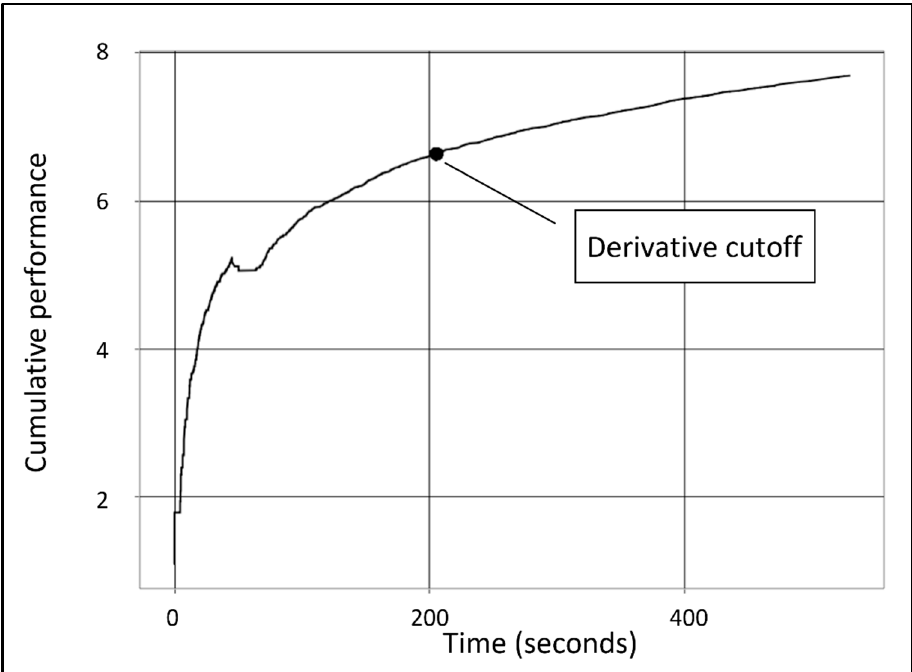
Figure 3. Learning curve for a single participant. X axis represents time (s), Y axis represents performance [Ln (cumulative hits − 10 * cumulative loss of lives)]. Black dot represents the first derivative cutoff point.